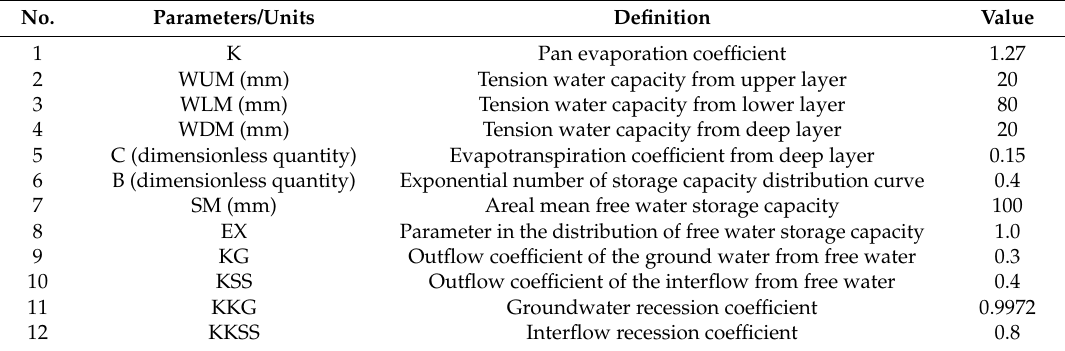
Figure 6. POD (a ) and FAR ( b ) of the IMERG_Cal and the IMERG_Uncal for daily precipitation thresholds, from April 2014 to December 2016 over the Nanliu River basin. Table 3. Calibrated parameters used in the Xinanjiang model for the Nanliu River